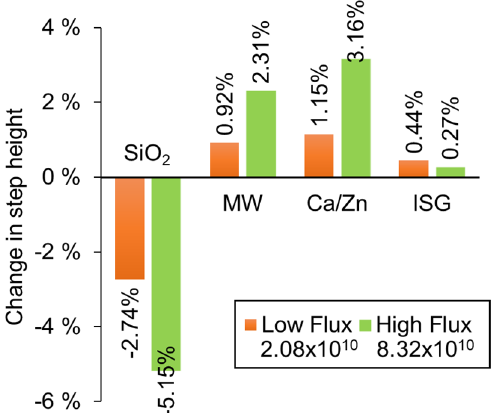
Figure 7. A determination of volume change for different glass compositions that have been exposed to Ni ions beams of two different fluxes (ions cm − 2 s − 1 ). For each composition, one part of each sample was masked from the ion beam so that a step was produced by the change in volume.